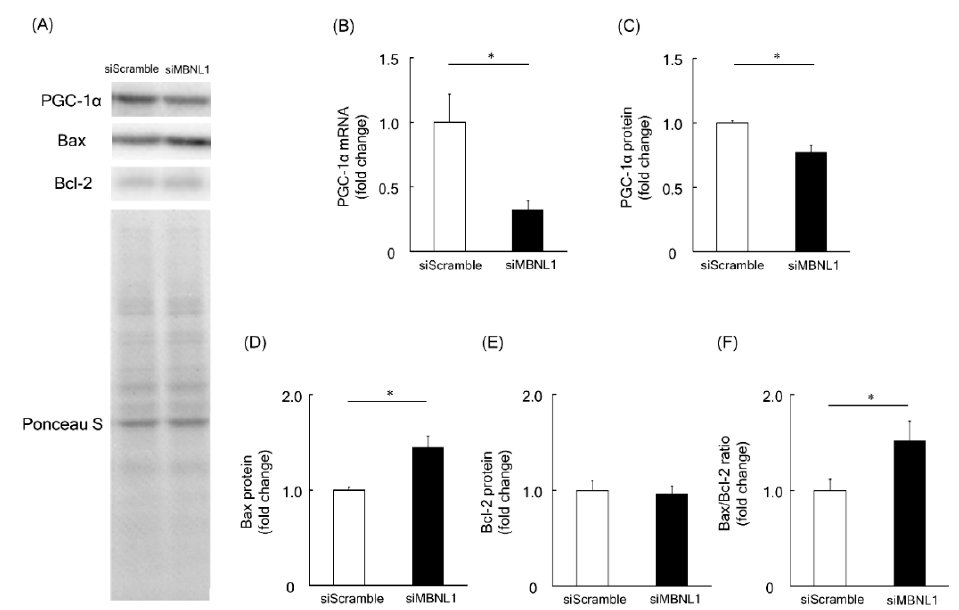
Figure 4. E ff ects of MBNL1 knockdown on the expression level of peroxisome proliferator-activated receptor- γ coactivator 1- α (PGC-1 α ), B-cell lymphoma 2 (Bcl-2) and Bcl-2-associated X protein (Bax) in C2C12 myotubes. ( A ) Representative expression patterns of PGC-1 α , Bax, Bcl-2, and loading control Ponceau S staining. ( B , C ) mRNA and protein expression level of PGC-1 α . The expression level of Bax and Bcl-2 proteins ( D , E ) and the ratio of Bax to Bcl-2 ( F ). Abbreviations are the same as in Figure 1. Values are means ± SEM; n = 6 per group. *: p < 0.05.